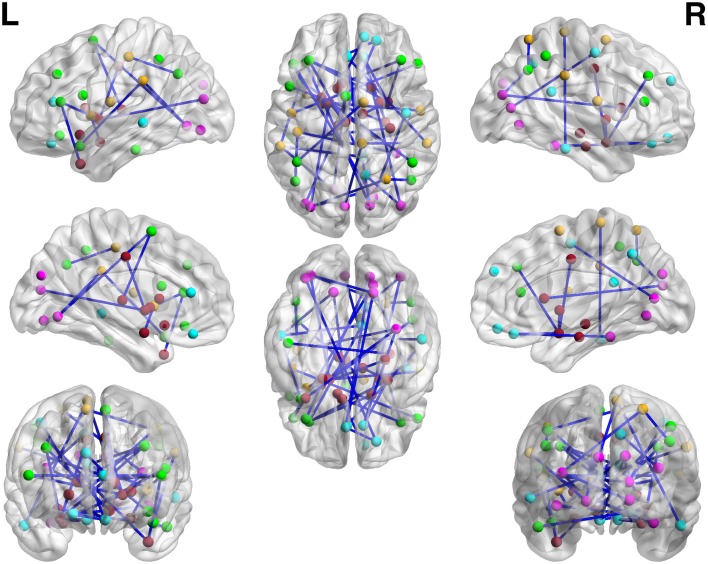
The regions showed higher correlations in children with ASD, compared to the TD group (q < 0.05, corrected for multiple comparisons). No pairs of regions showed higher connectivity in the TD than the ASD group.